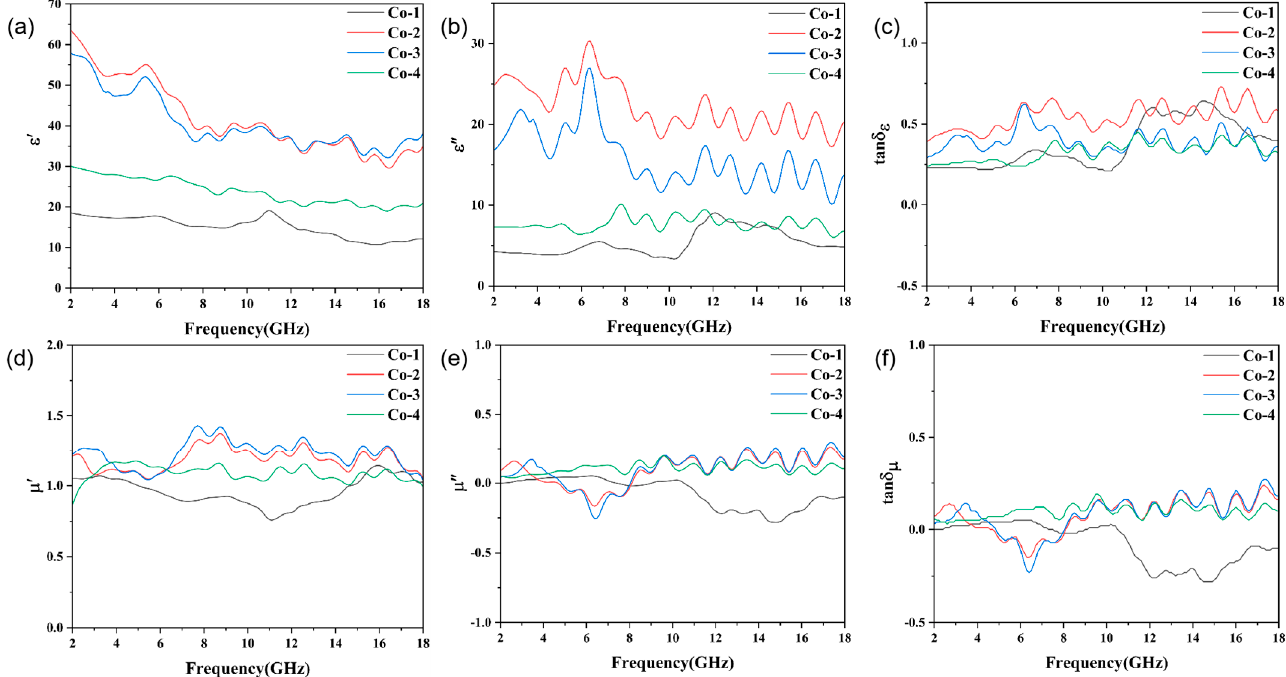
Figure 6. Electromagnetic parameters of Co-1, Co-2, Co-3, Co-4: ( a ) 𝜀 (cid:4593) , ( b ) 𝜀 (cid:4593)(cid:4593) , ( c ) dielectric loss an- gle tangent factor tan 𝛿 (cid:3084) , ( d ) 𝜇 (cid:4593) , ( e ) 𝜇 (cid:4593)(cid:4593) , ( f ) magnetic loss angle tangent factor tan 𝛿 (cid:3091) . tangent factor tan δ ε , ( d ) µ (cid:48) , ( e ) µ (cid:48)(cid:48) , ( f ) magnetic loss angle tangent factor tan δ µ